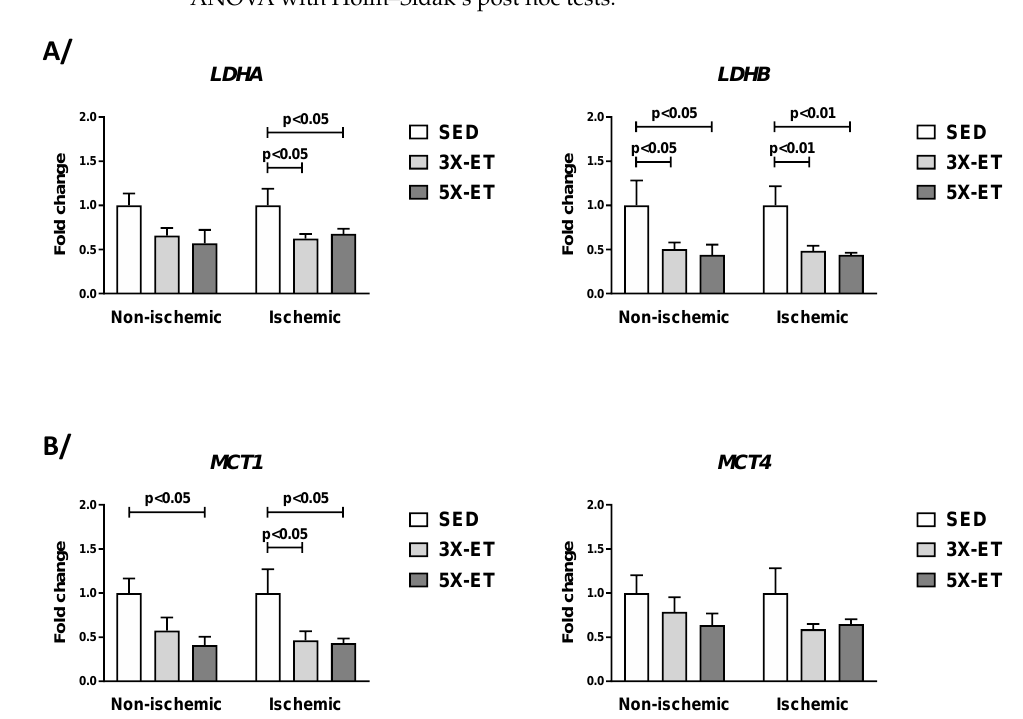
Figure 2. Expression of genes involved in glucose transport ( GLUT1 and GLUT4 ) ( A ), glycogen synthesis ( GYS1 ), ( B ) and glycolysis ( HK2 , PFK, and PDK4 ) ( C ) in non-ischemic and ischemic muscles of sedentary (SED), three times (3X-ET), and five times (5X-ET) a week exercised ApoE −/− mice with PAD. Data were normalized to 36B4 gene and expressed as fold-change over respective SED group. Results presented as the mean ± SEM ( n = 6–8 mice per group). Data were analyzed using one-way ANOVA with Holm–Sidak’s post hoc tests.